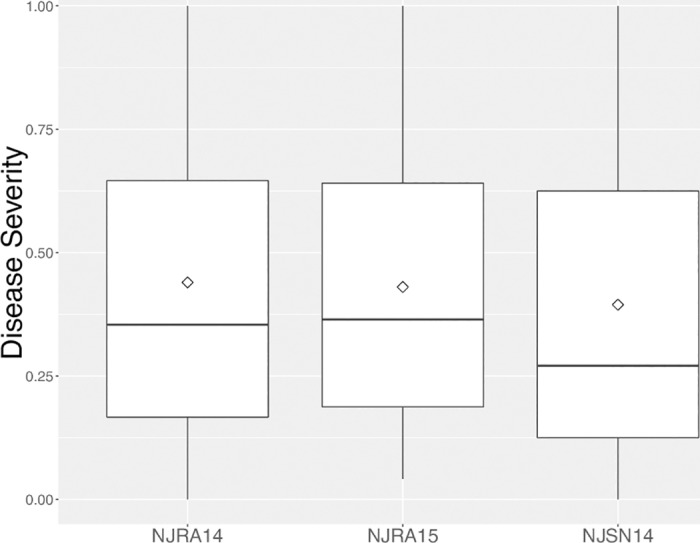
Frequency distribution of disease severity in the MRI x SB22 F2 mapping population across three environments.Codes for each environment are shown on the x-axis and correspond to data recorded in 2014 in southern New Jersey (NJRA14), 2015 in southern New Jersey (NJRA15) and northern New Jersey in 2014 (NJSN14). Disease severity measured on a scale in which 0 = lowest possible severity score and 1 = highest possible severity score.